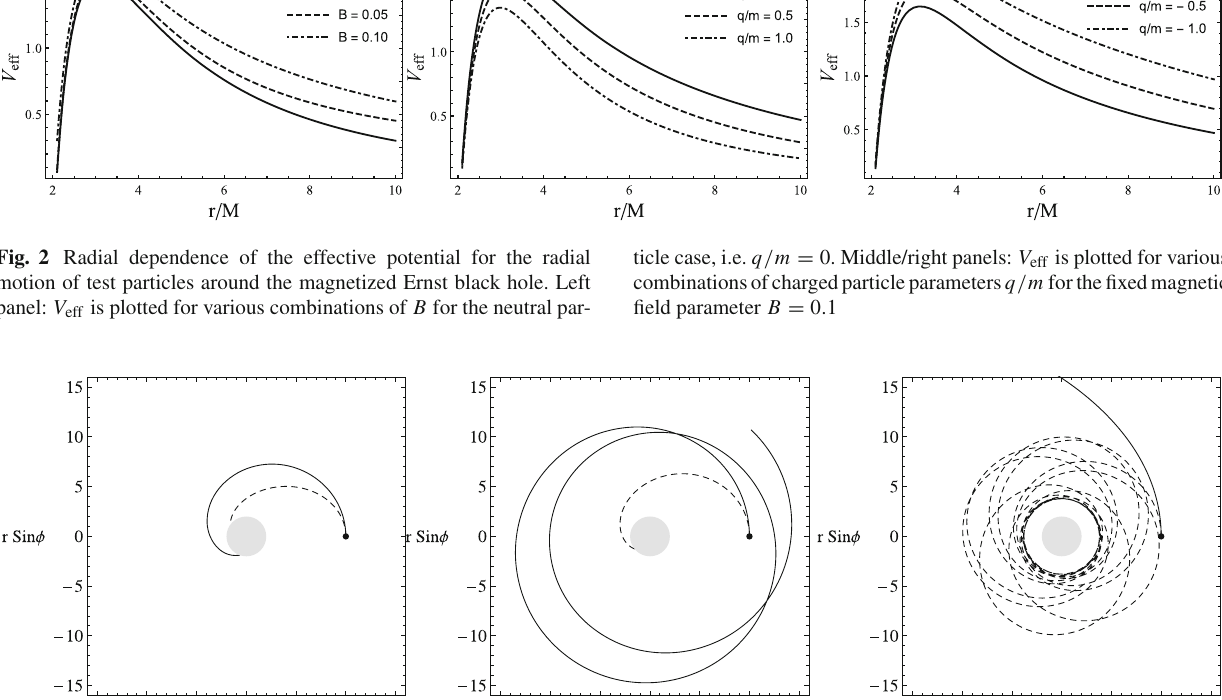
Fig. 3 Trajectories of the particle at the equatorial plane around the magnetized Ernst black hole for magnetic field parameter B = 0 (solid curve) and B = 0 . 04 (dashed curve) for various combinations of angu-